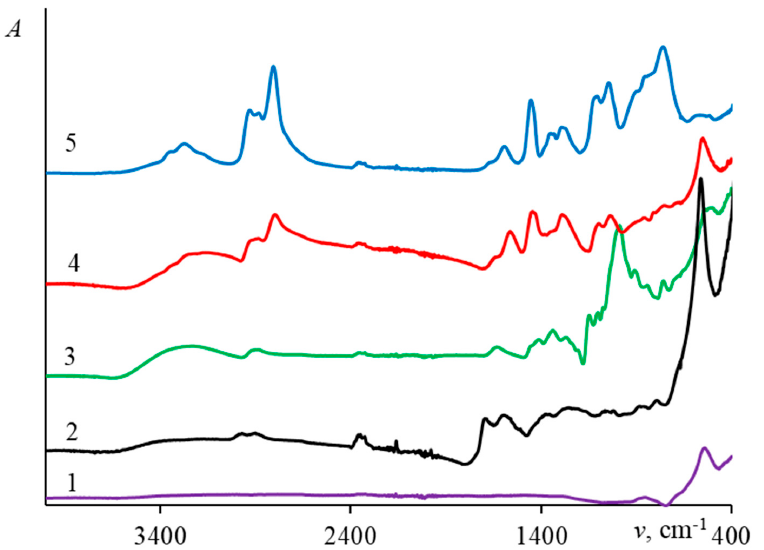
Figure 2. IR spectra of IONs covered by different surface modifiers: (1)—Fe 3 O 4 , (2)—Fe 3 O 4 @Carb,